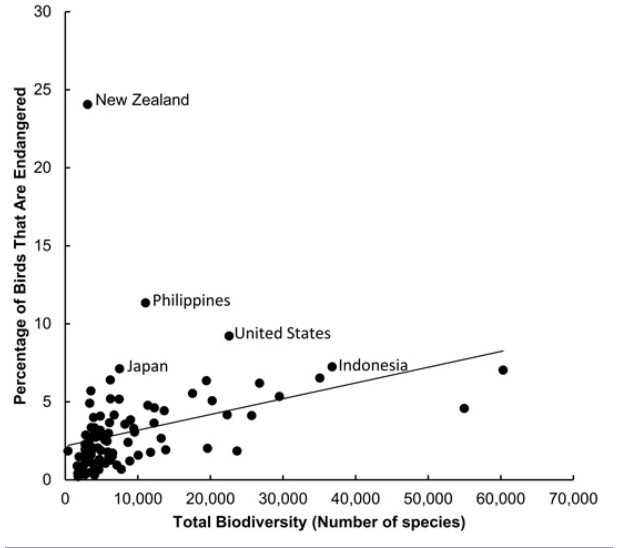
Fig. 1 . One of the two models best explaining the proportion of endangered birds was the total biodiversity in a country. The proportion of endangered birds ranged from 0.21% to 24.05% and total biodiversity ranged from 380 species to 60,322 species. New Zealand is an extreme outlier.